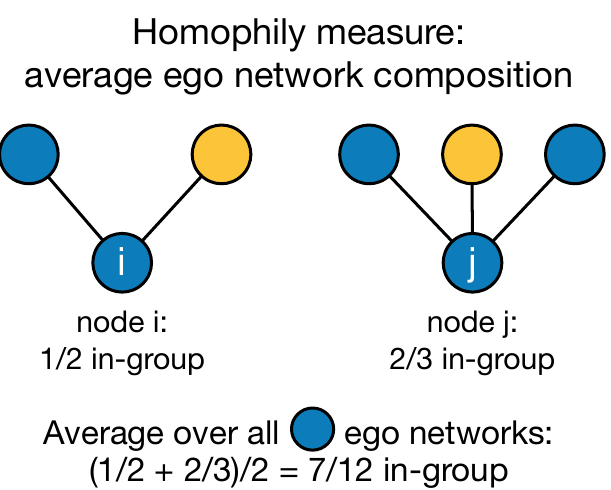
Figure 2: We use average ego network composition to capture homophily from the perspective of the blue nodes. We assume node categories (blue and yellow) must be predicted with a model. This estimand is expressed analytically in Equation